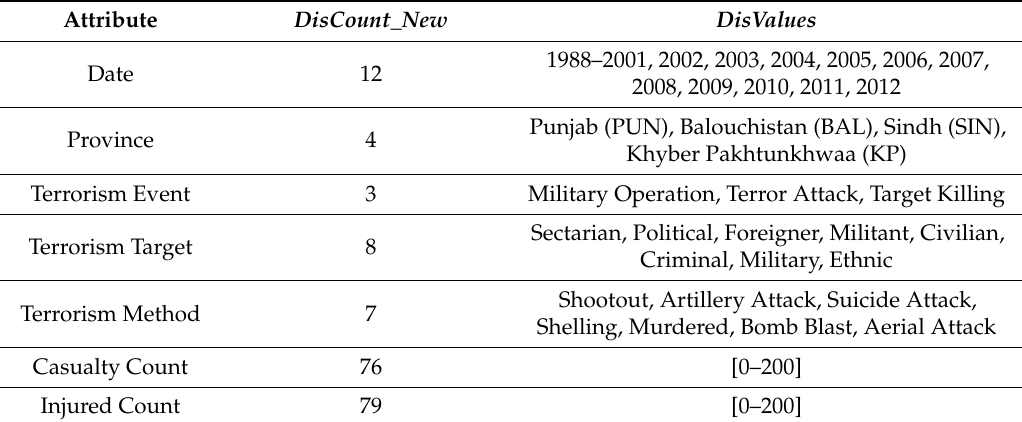
Table 4. The final terrorism data set with discretizations; Attribute = attribute label, DisCount_New = Reduced number of discretizations, and DisValues = The discretized values.